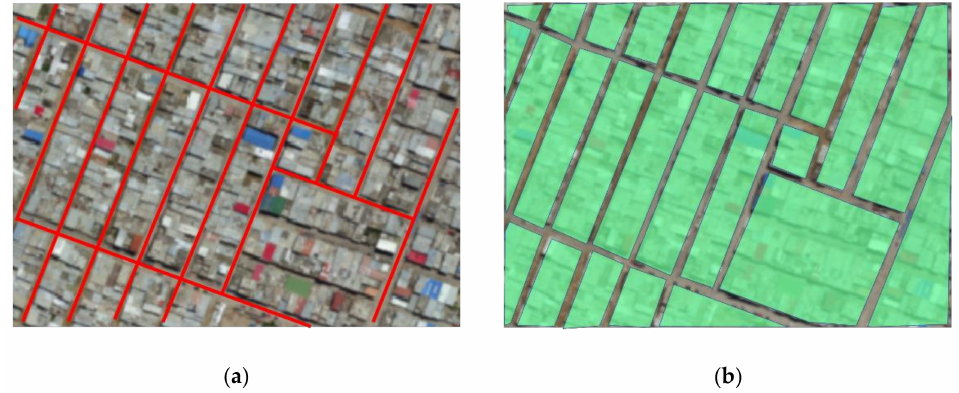
Figure 13. Detect building areas ( a ) detect roads in images; ( b ) detect areas where buildings are